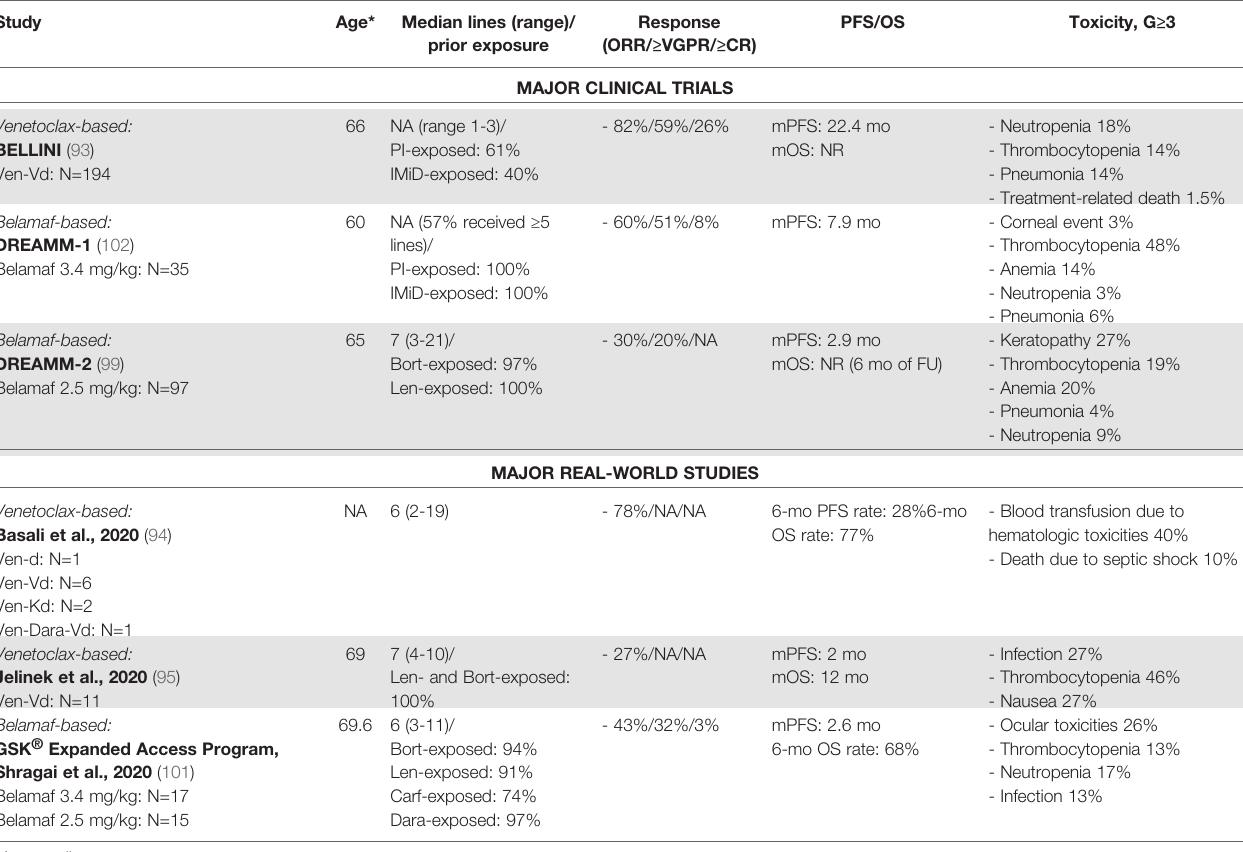
TABLE 7 | Major clinical trials and real-world studies based on other novel agents (monoclonal antibodies and small molecules) for the treatment of RRMM. Study Age* Median lines (range)/